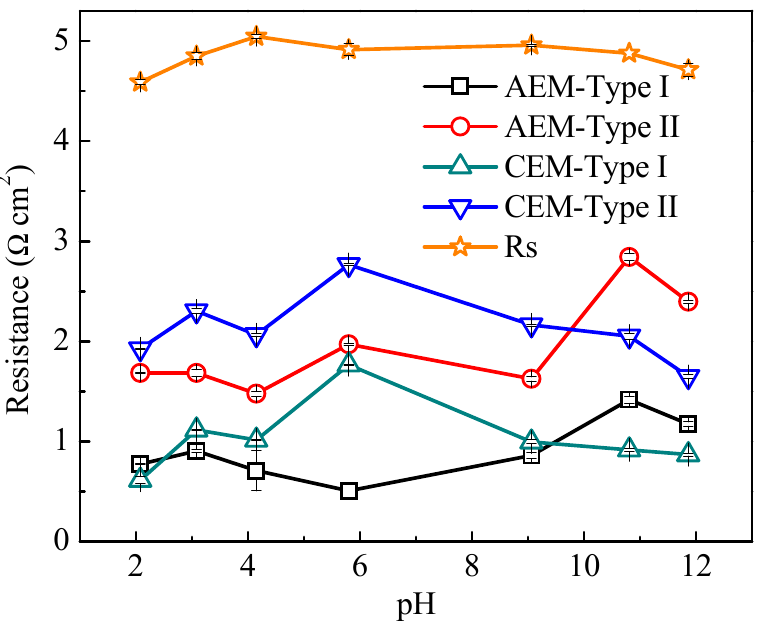
Figure 8. Area membrane resistance (R A ) of four ion exchange membranes and solution resistance (R s ) as a function of pH value in 0.5 M NaCl solution.